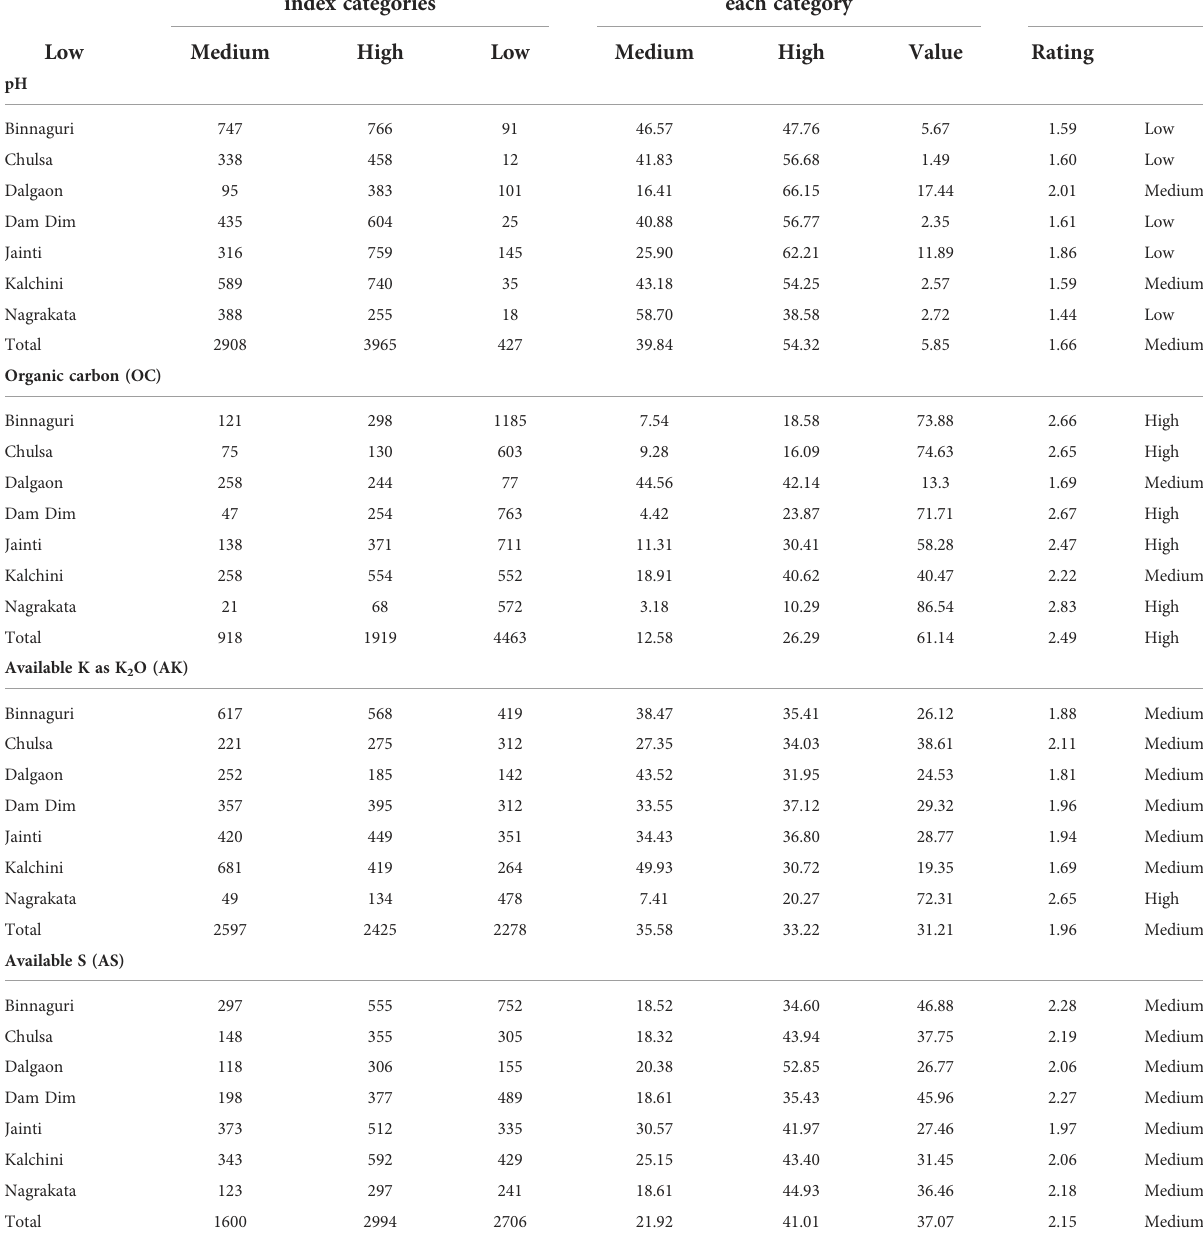
TABLE 2 Frequency of soil samples falling in the indices categories, percent (%) of soil samples under each category, and Nutrient Index value as well as rating in the Dooars tea growing region of West Bengal, India covering seven sub-districts based on soil pH, organic carbon (OC), available K as K 2 O (AK) and available S (AS) (total number of soil samples: 7300; the total number of tea estates: 115 and number of replications for each